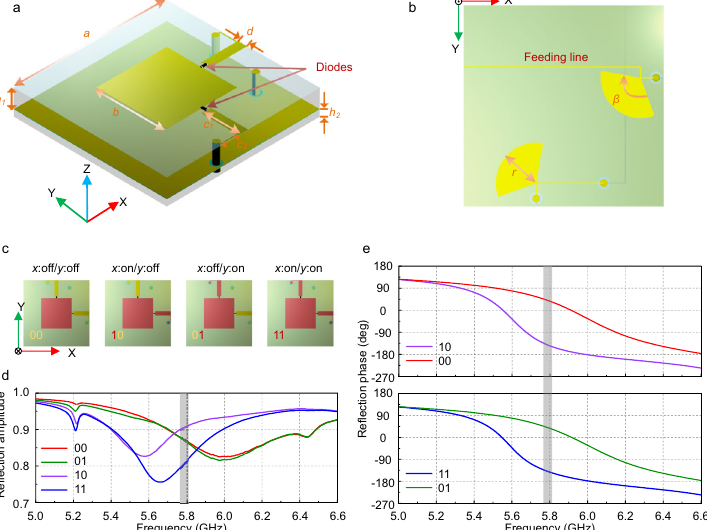
Fig. 2 | The structure and performance of the designed DPM. a The element structure integrated with two PIN diodes, and the geometric parameters are designed as follows: a =25mm, b =11.5mm, c 1 =6mm, c 2 =2.8mm, h 1 =3 mm, d =1.5mm. b The bottom view of the coding element. c The h 2 =1 mm and